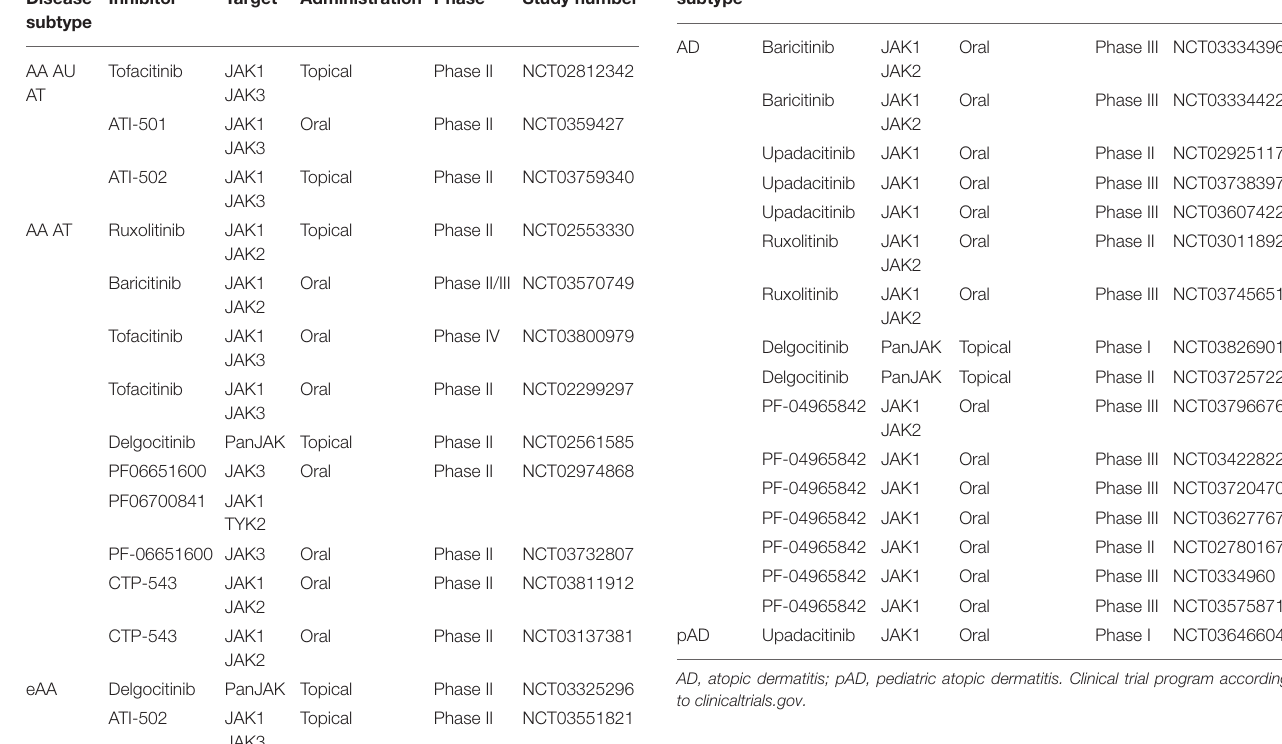
TABLE 2 | Clinical trial program of JAKi in alopecia areata and subtypes according to clinicaltrials.gov. Disease Inhibitor subtype